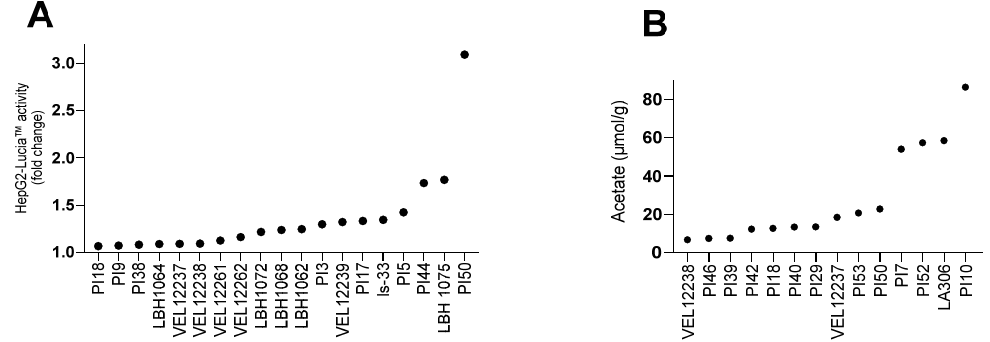
Figure 6. Metabolite production for bacterial strains screened in this study. ( A ) Induction of AhR activity by bacterial supernatants (only strains inducing activity >1 are represented). Supernatants were co-incubated at 2% final concentration for 24h in triplicate on HepG2-Lucia™ reporter cells. After incubation, AhR activation was assessed by determining Lucia luciferase activity in the supernatant using QUANTI-Luc™. Induction of HepG2-Lucia™ is represented as fold-change activity compared with noninduced cells (incubation with growth medium only). Results were normalized on the basis of the cytotoxicity measurement. ( B ) Acetate production in the supernatants (only strains with a net acetate production are represented). Each strain was tested once in technical duplicates. Quantification threshold for acetate: 0.1 mM.